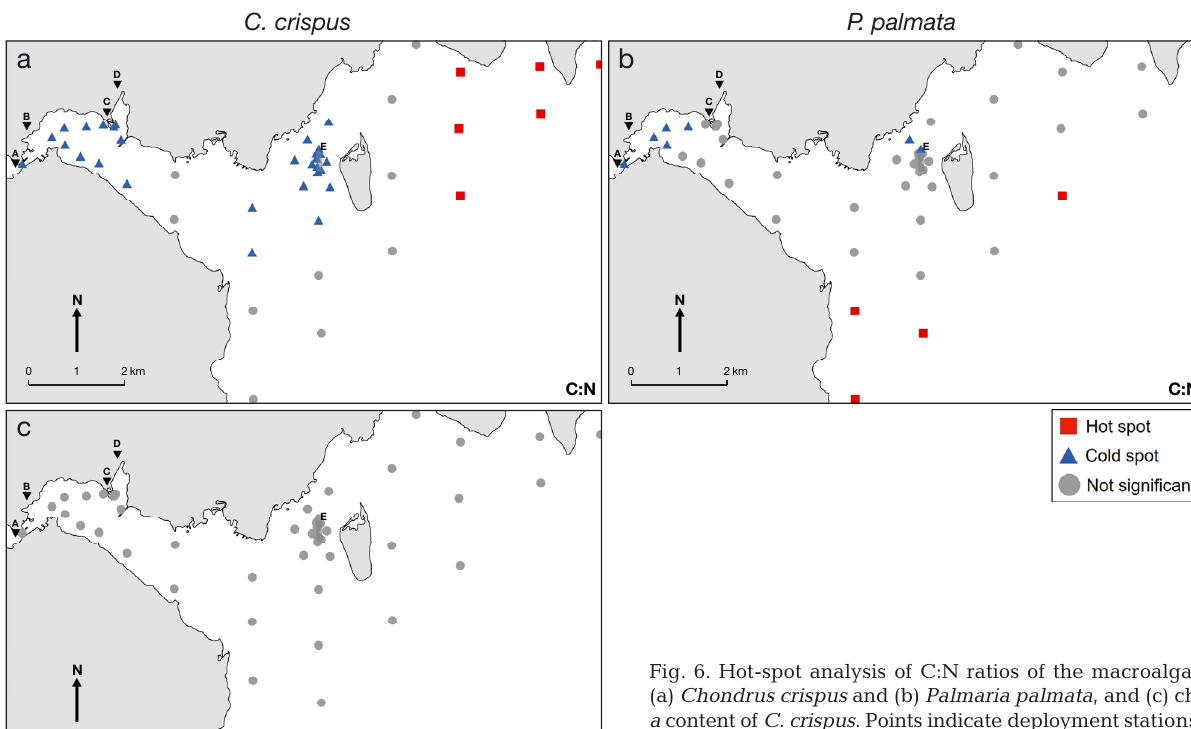
Fig. 6. Hot-spot analysis of C:N ratios of the macroalgae (a) Chondrus crispus and (b) Palmaria palmata , and (c) chl a content of C. crispus . Points indicate deployment stations. Triangles indicate probable point sources (labelled as in Fig.